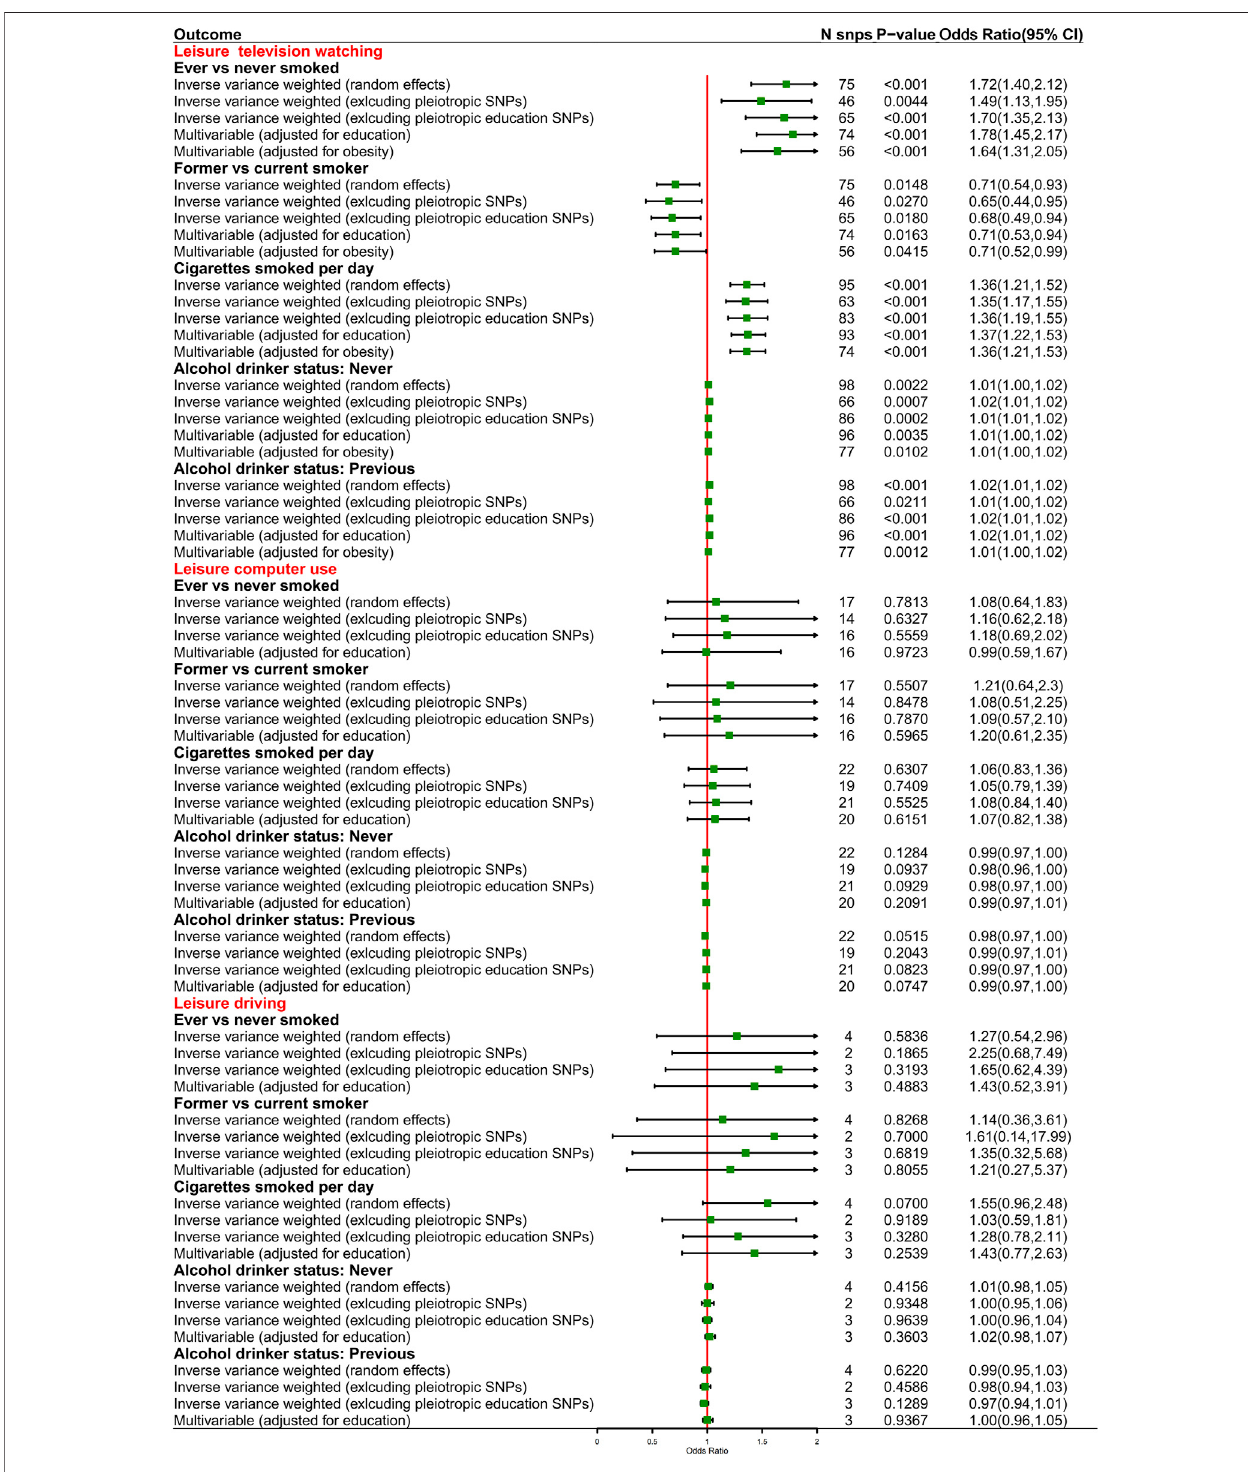
FIGURE 4 | Causal effects from genetically predisposed prolonged leisure sedentary behaviors and mediators.